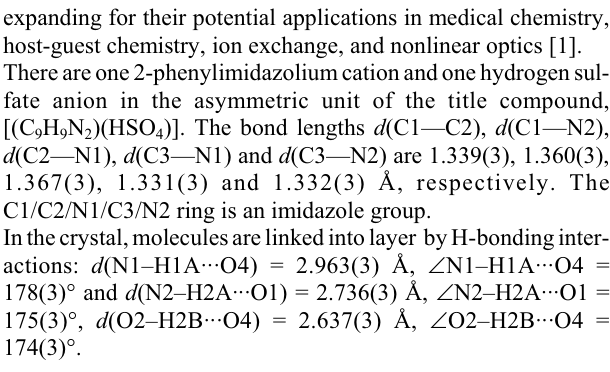
Table 1. Data collection and handling.